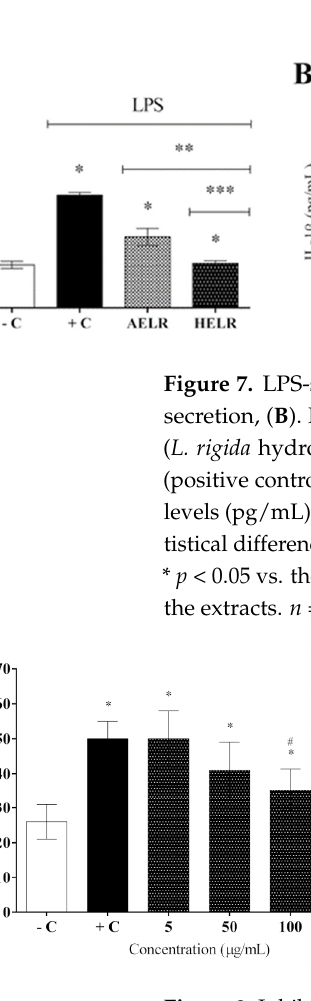
Figure 8. Inhibitory effects of L rigida extracts on LPS-stimulated nitric oxide (NO) production in RAW 264.7 macrophages: ( A ) AELR and ( B ) HELR. The NO level in the culture medium was quantified using Griess reagent. Data represent the mean ± SEM from three independent experiments. One-way ANOVA was used followed by a post hoc Tukey test. * p < 0.05 vs. the negative control group; # p < 0.05 vs. the LPS-stimulated cells.